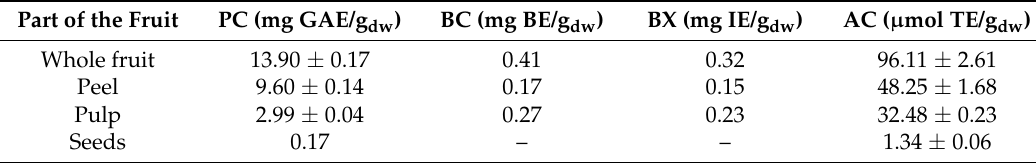
Table 2. Characterization of dry whole purple cactus pear fruit and its separate parts (peel, pulp, and seeds).